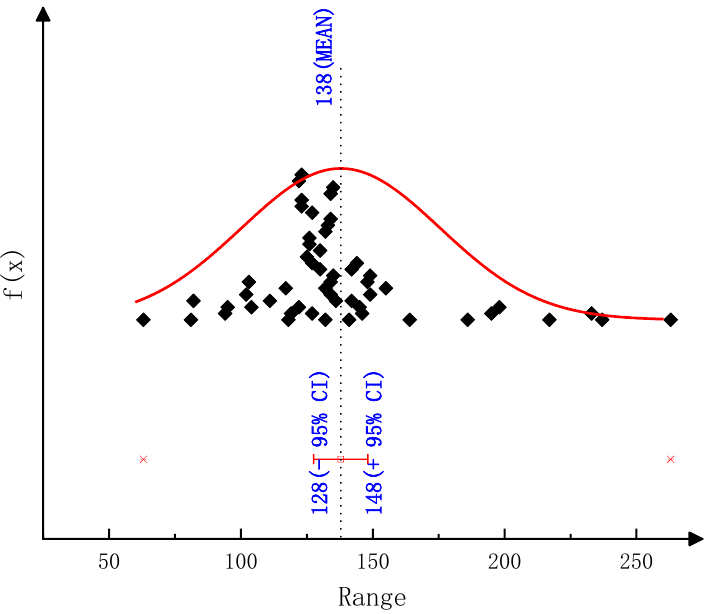
Figure A6. 95% confidence interval for the activation energy E F,2 of CYA pyrolysis reaction.